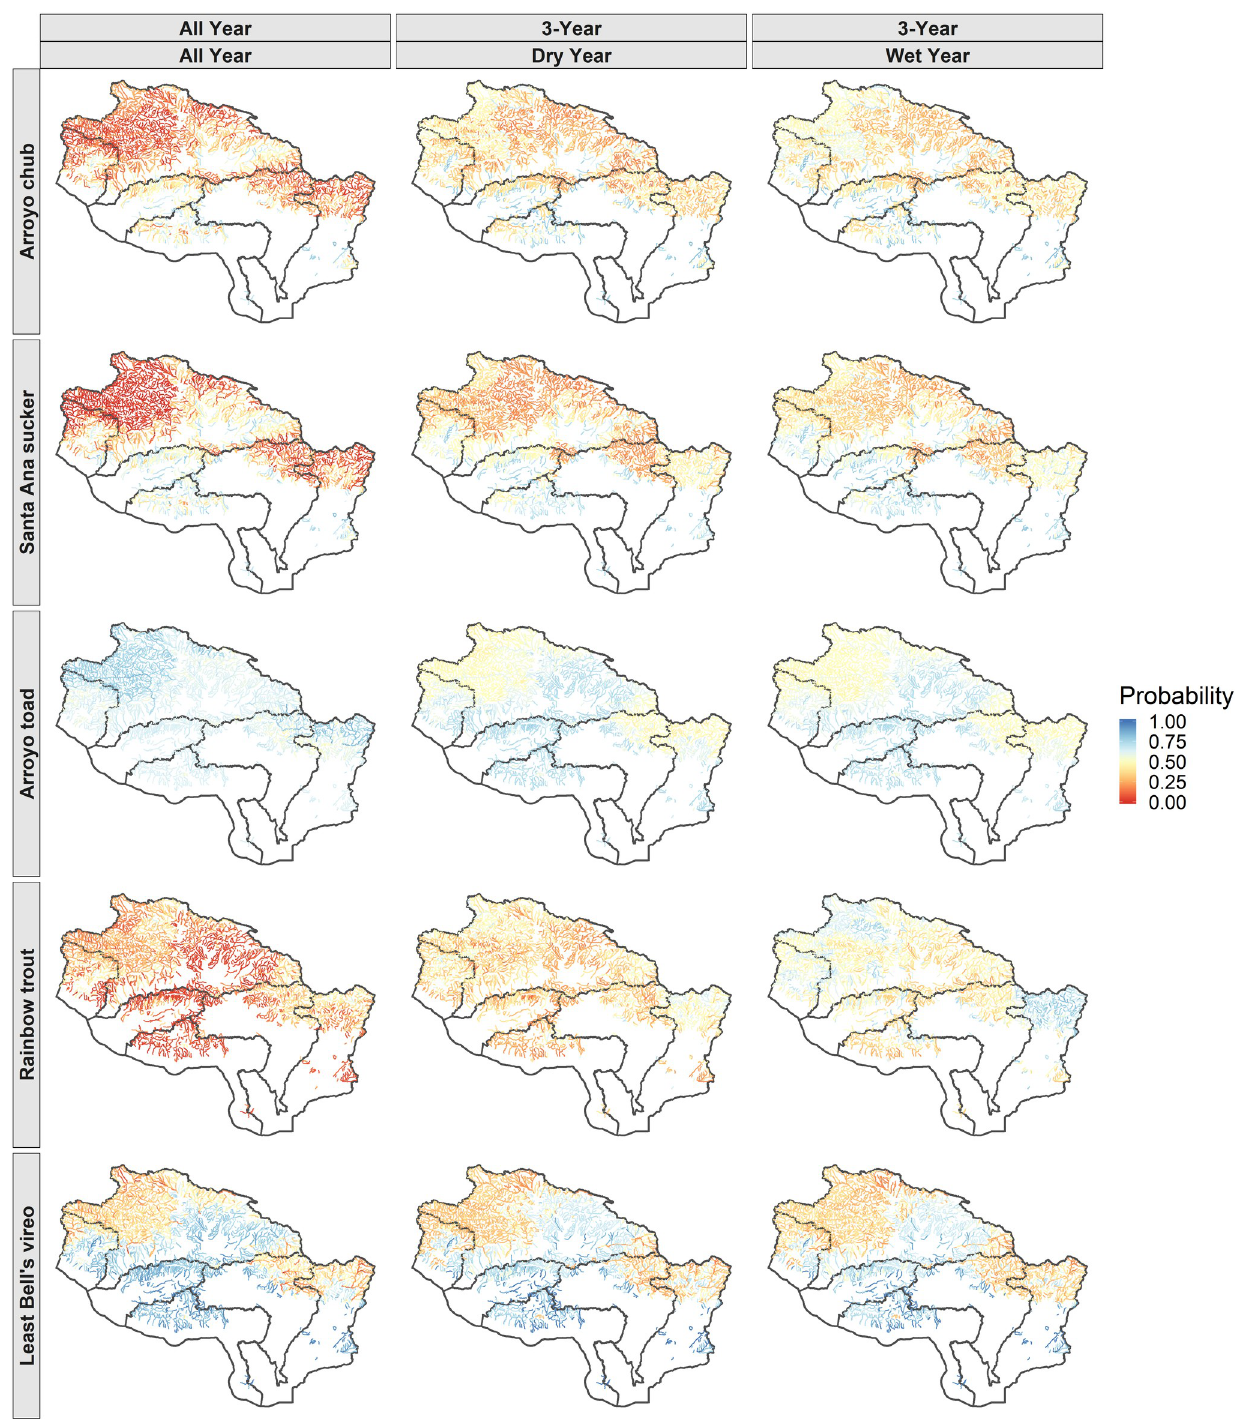
Fig 6. End-of-century probability of occurrence predictions using the all-year predictors and the 3-year predictors. The first column shows the predicted end-of-century probabilities using streamflow data from a long-term timeseries including the entire timeseries of forecasted years. The middle column shows predicted end-of-century probability in a three year dry period, and the last column shows predicted end-of-century probability in a three year wet period.